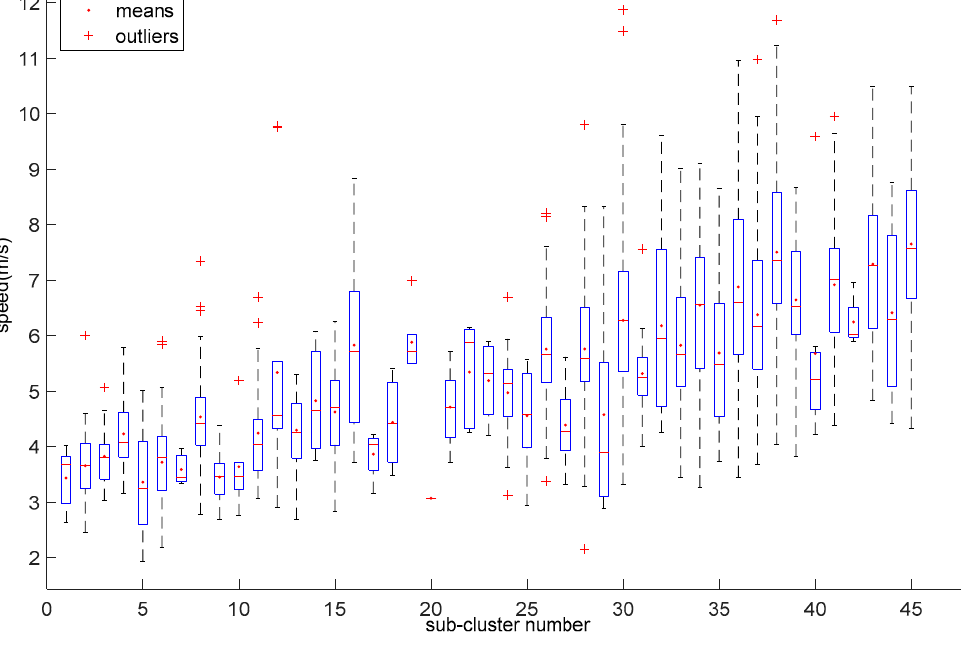
Figure 4. Data Description for 45 Speed Subsets.